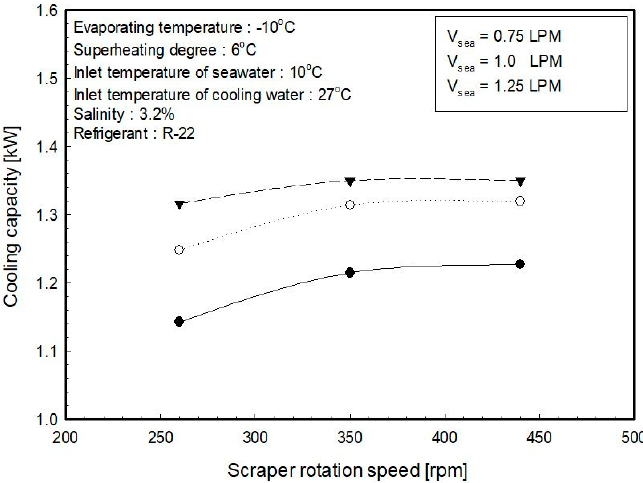
Figure 13. Cooling capacity with respect to scraper rotation speed.